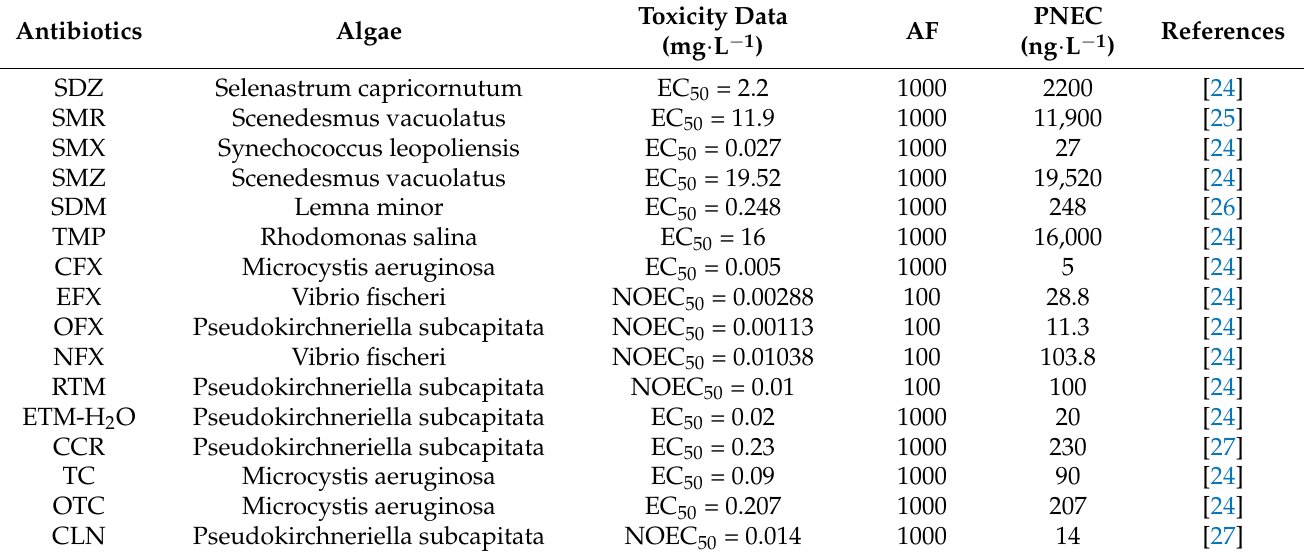
Table 2. Toxicity data of antibiotics, AF value and PNEC value.